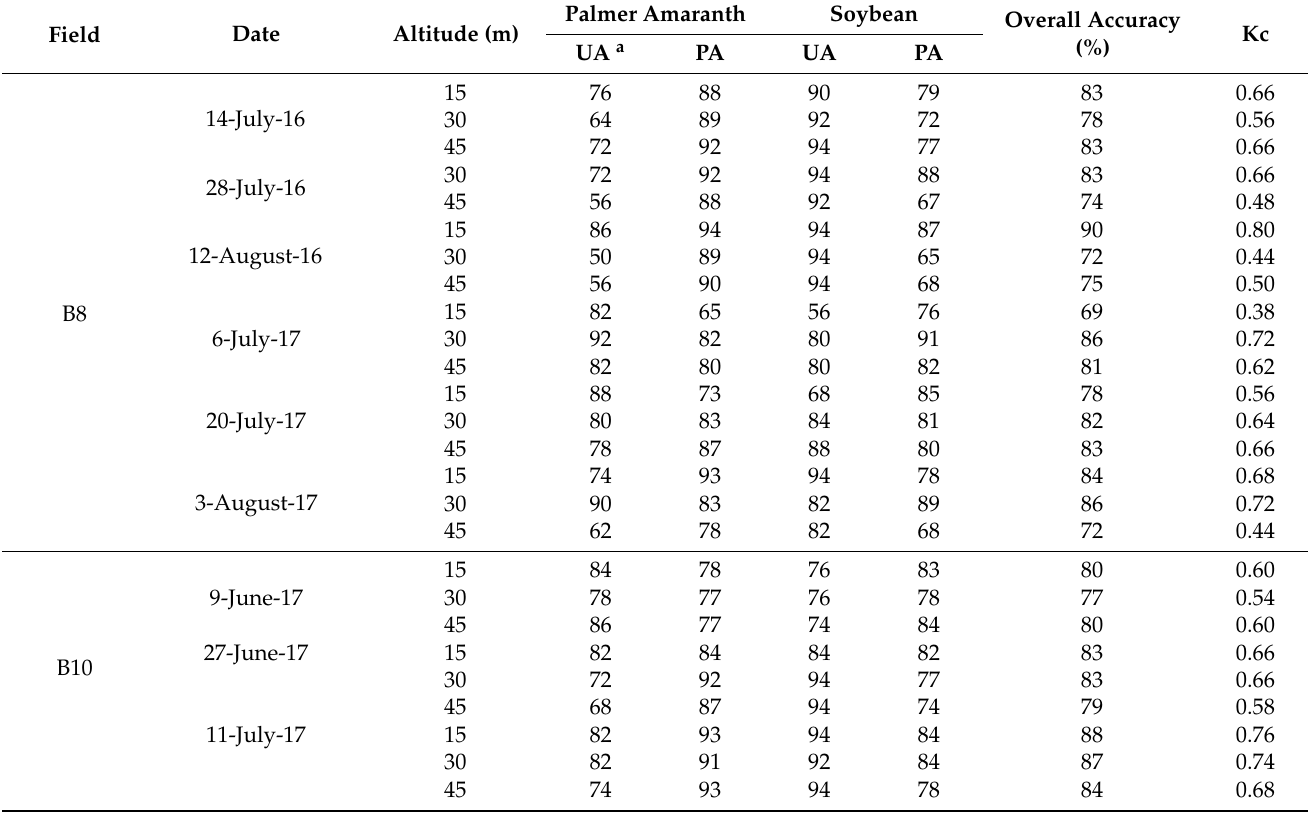
Table 8. Summary of the two-class supervised classification accuracies for Palmer amaranth and soybean detection growing in mixed stands from aerial imagery collected from different altitudes at two separate fields at Rocky Mount, NC in 2016 and